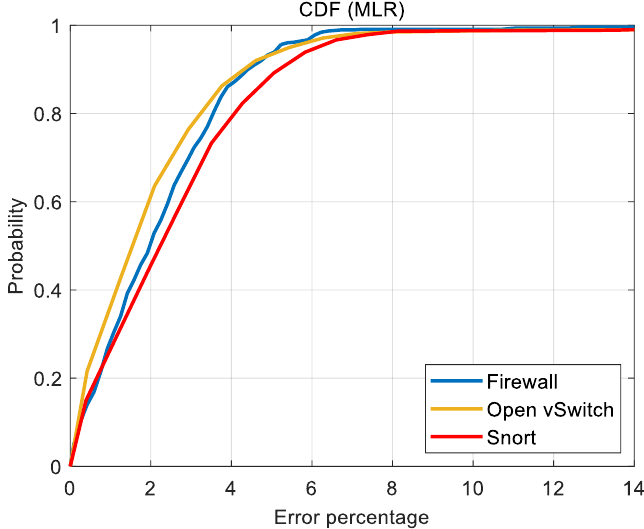
Figure 10. CDF of percentage prediction errors of MLR.